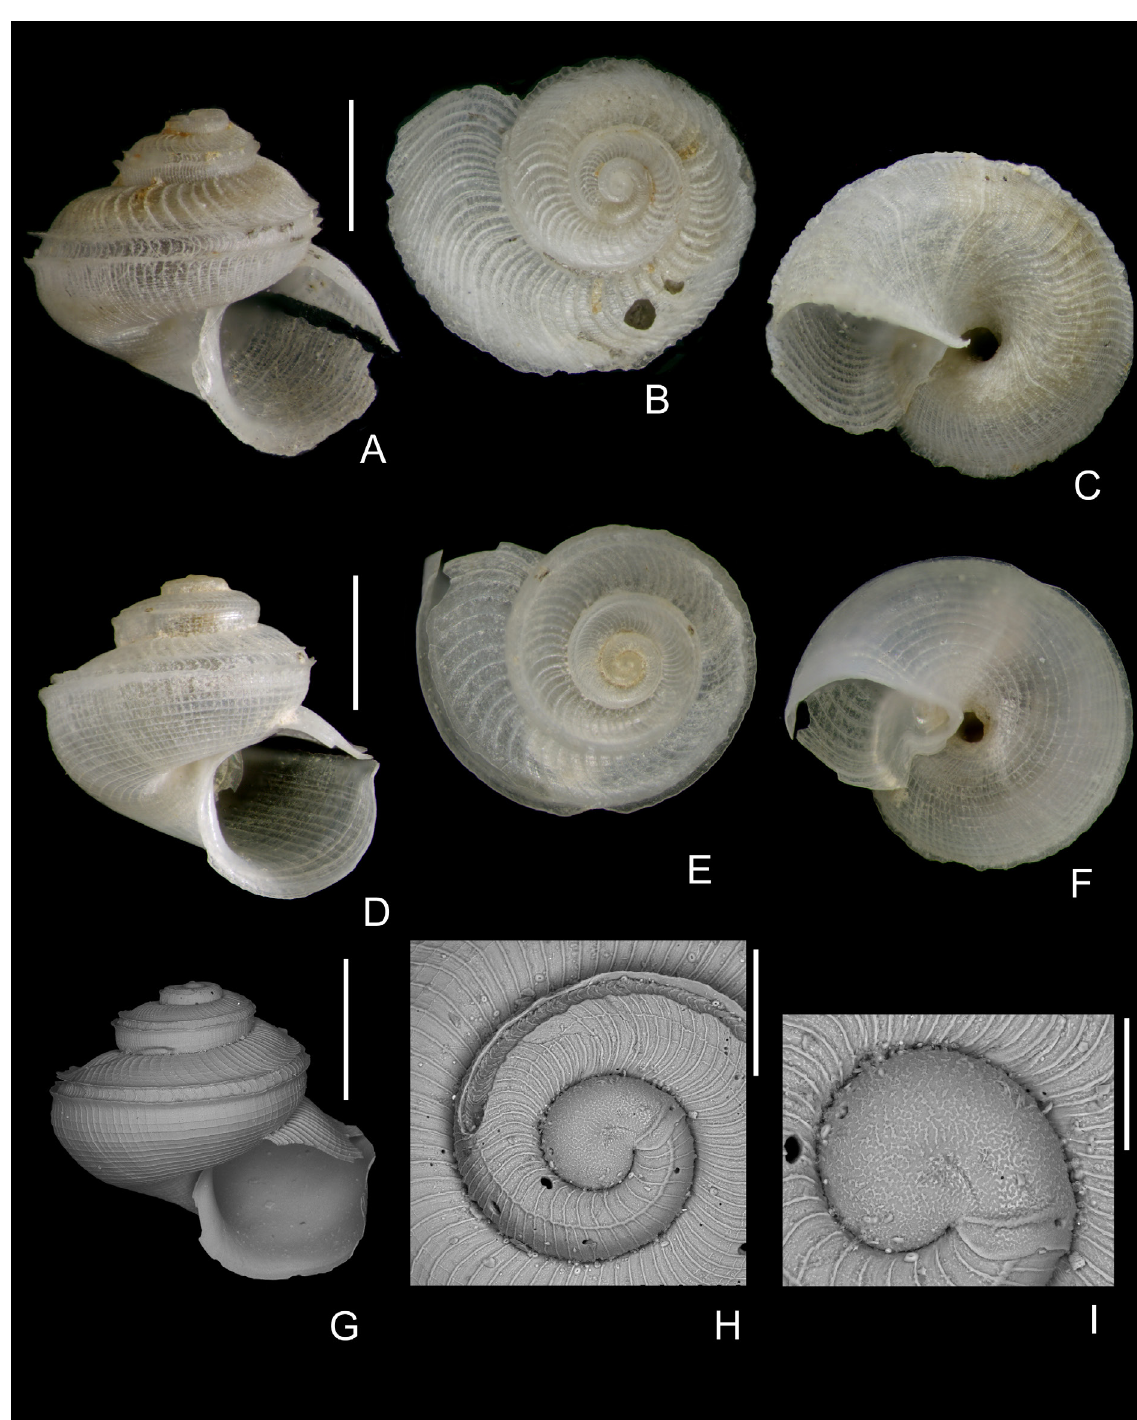
Fig. 8. Anatomidae 2. A–C . Anatoma aspera (Philippi, 1844), SEAMOUNT 1, DW116, 985–1000 m, diameter 2.8 mm. D–F . Anatoma eximia (Seguenza, 1880), SEAMOUNT 1, DW116, 985–1000 m, diameter 2.5 mm. G . A . eximia , SEM micrograph, BANGAL 0711, V4, 744 m, diameter 2.3 mm. H–I . A. eximia , SEM micrograph, details of protoconch and early teleoconch whorls of another shell, same locality. Scale bars: A–G = 1 mm; H = 200 µm; I = 100